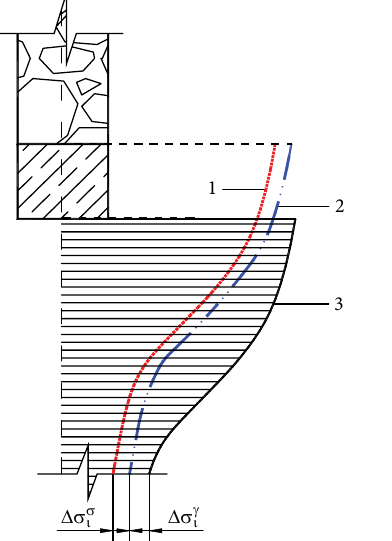
stress before renovation; 2 – s i stress increasing additional i